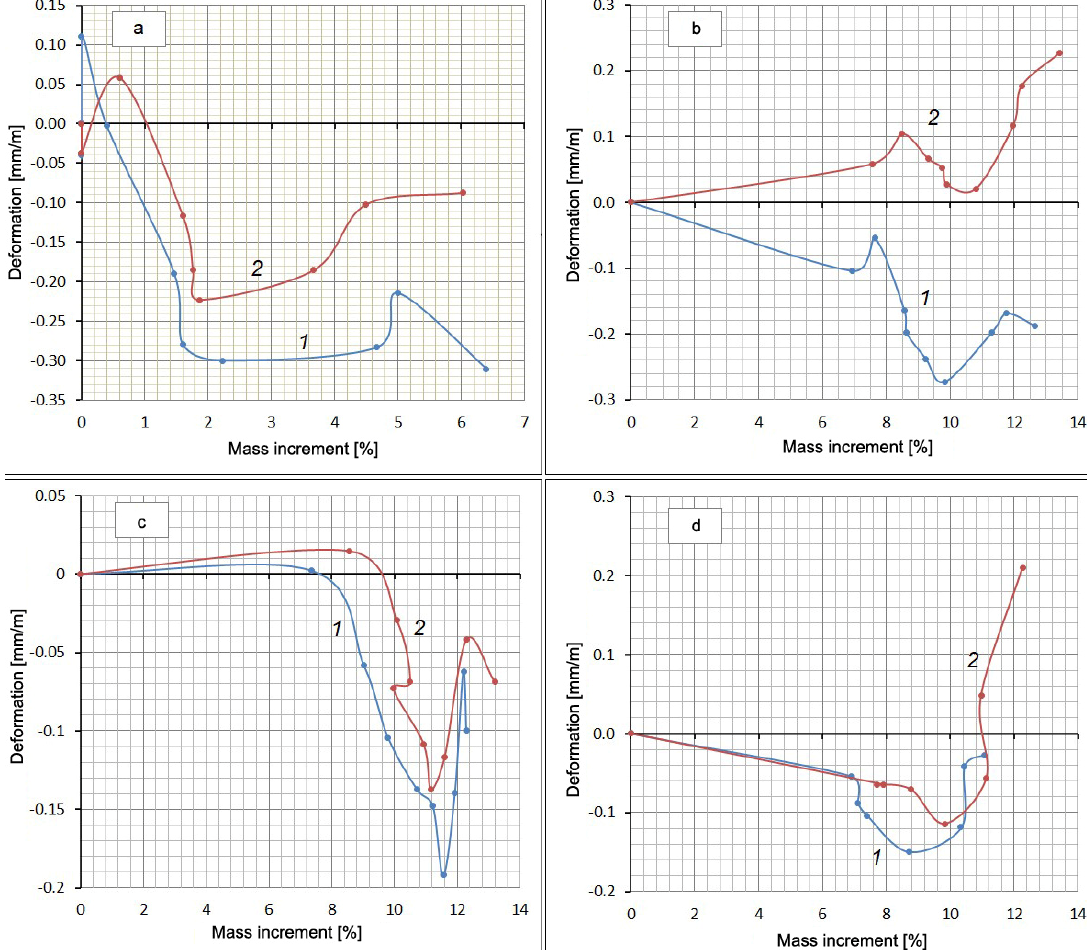
Figure 4. Deformation of compositions depending on the amount of absorbed substance: ( a ) Control Mix; ( b ) mix with Zolest-bet additive (Mix No. 1); ( c ) mix with silica fume additive (Mix No. 2); ( d ) sulfate-resistant Portland cement (Mix No. 3); 1—at water hardening; 2—at 5% Na 2 SO 4 solution hardening.